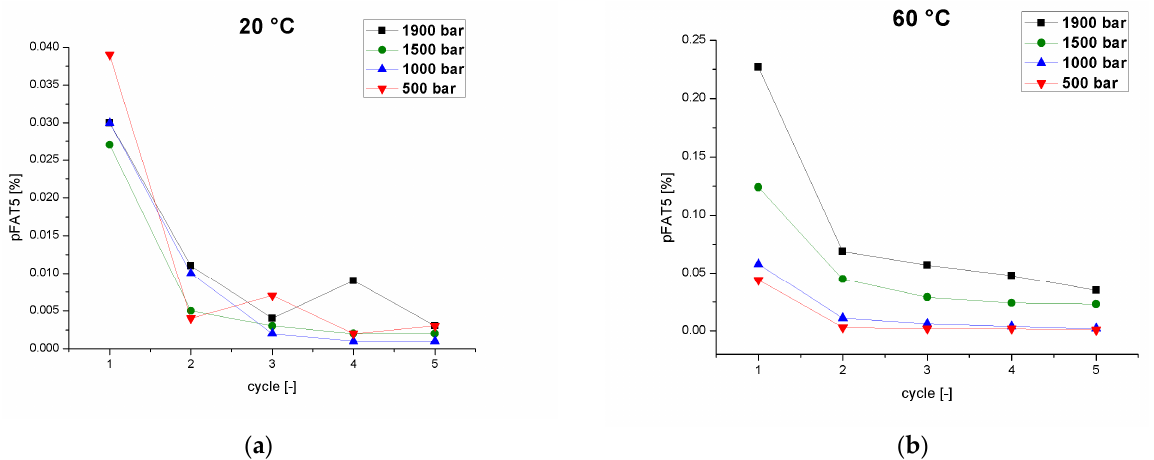
Figure 4. The pFAT5 value as a function of the number of cycles at different operating pressures (500–1900 bar) and two different temperatures. ( a ) Emulsion temperature at the inlet of the homogenizer = 20°C. ( b ) Emulsion temperature at the inlet of the homogenizer = 60°C.